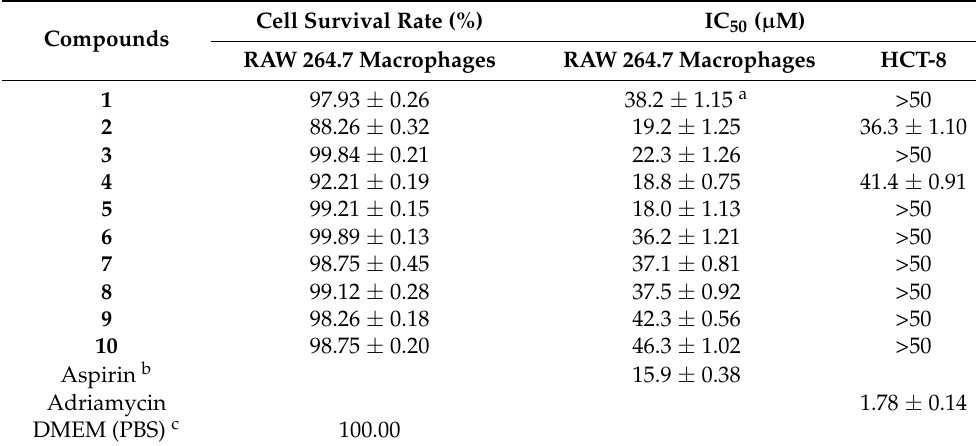
Table 2. Anti-inflammatory and cytotoxic activities of the isolated compounds. Cell Survival Rate (%) IC 50 ( µ Compounds